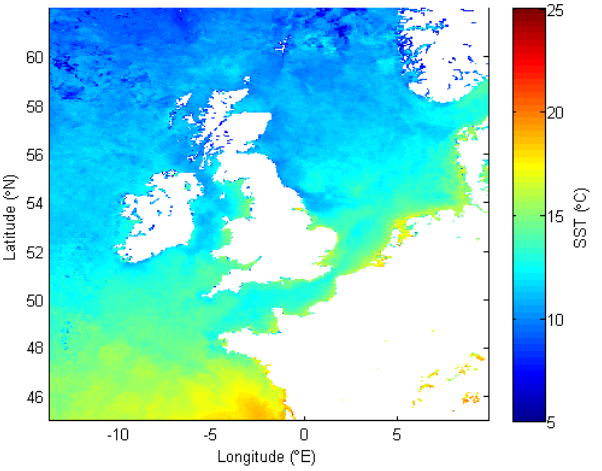
Figure 4. Aqua MODIS monthly composite satellite image of chlorophyll concentration across the study area in June